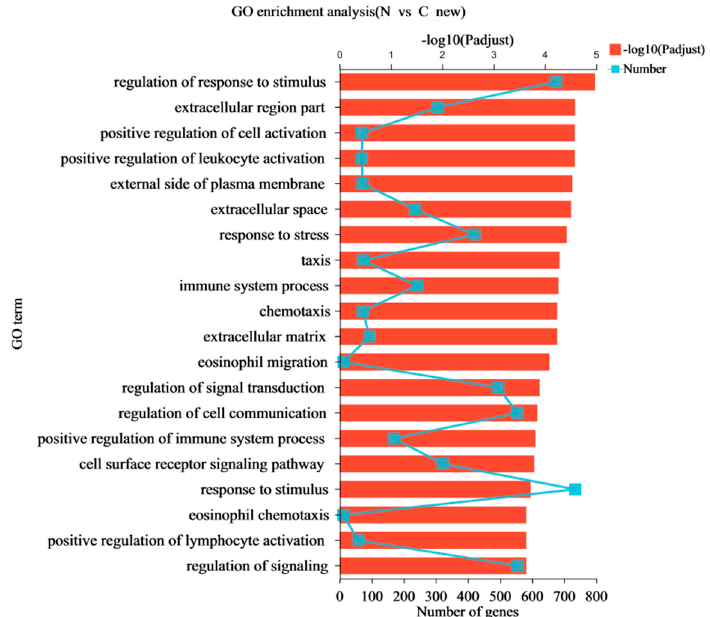
Figure 5. Up-regulated and down-regulated genes were obtained using Genetic Ontology enrichment analysis ( p < 0.05). The x -axis at the bottom indicates the number of genes corresponding to the points on the broken line. The x -axis at the top indicates the significance of enrichment corresponding to the bar’s height. Table 7. Representative results of Gene Ontology and Kyoto Encyclopedia of Genes and Genomes (KEGG) pathway enrichment of differentially expressed